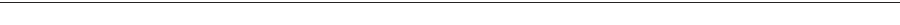
FIGURE8(Continued) *** p < 0.001, one-way ANOVA followed by Dunnett’s test. (B) Activation traces (left) and dose-response curve (right) of R-CaMP2 in neurons co-expressed with hK2 α P212L in response to 30 photo-stimulations delivered at 20Hz under 0, 1, 10, 100 µ M Memantine. n = 22 for 0 µ M, 27 for 1 µ M, 23 for 10 µ M and 22 for 100 µ M. *** p < 0.001, one-way ANOVA followed by Dunnett’s test. (C) Activation traces (left) and dose-response curve (right) of hK2 α WT in response to 30 photo-stimulations delivered at 20Hz under 0, 1, 10, 100 µ M memantine. n = 22